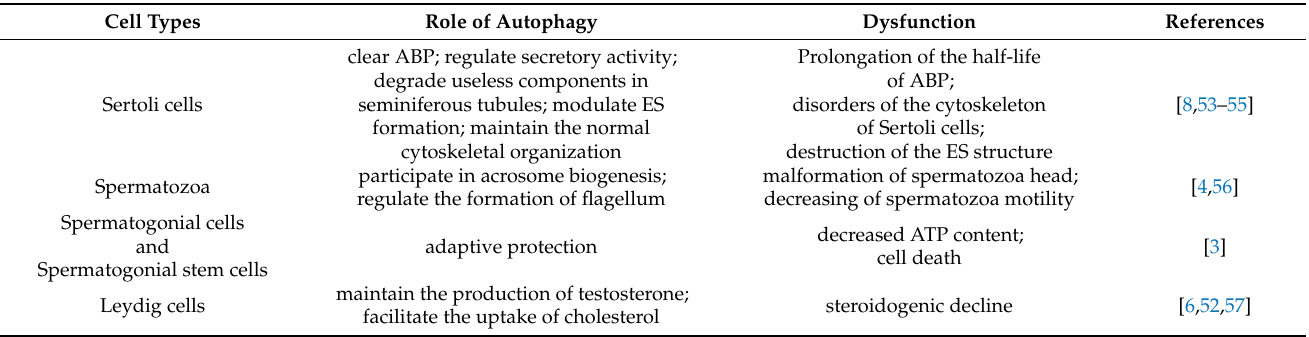
Table 1. Physiological roles of autophagy in testicular